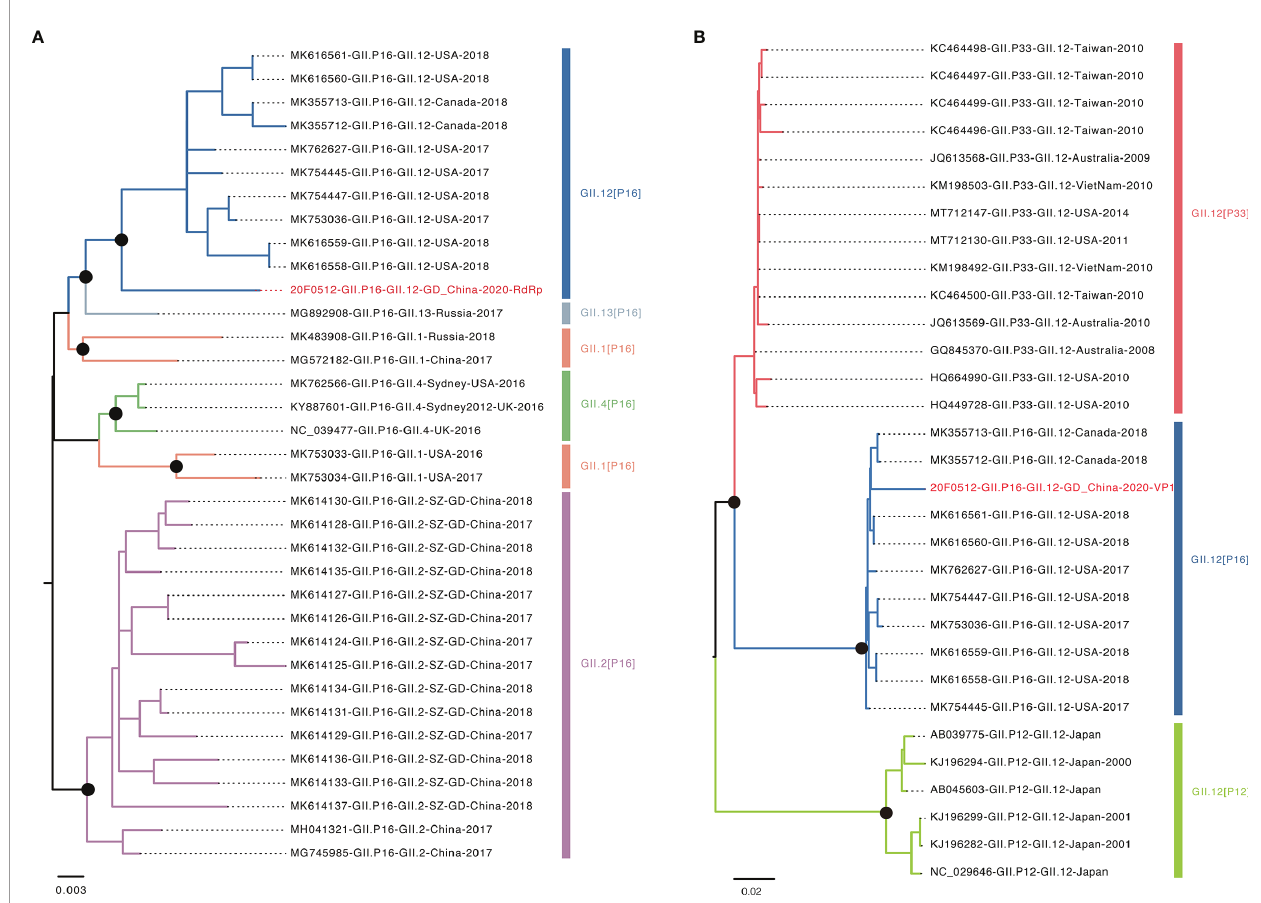
FIGURE 4 | Phylogenetic analysis of VP1 and RdRp genes. (A) Phylogenetic tree of RdRp region. Different colors indicated various genotype. The red highlighted sequence represents RdRp gene of this outbreak. (B) Phylogenetic tree of VP1 region. The red highlighted represents VP1 gene of this outbreak. Black dots indicate bootstrap support >80 at the root node of selected